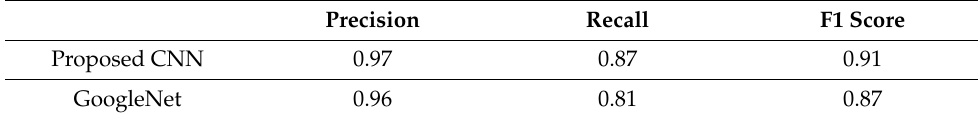
Table 7. CNN model Performance Indicators.